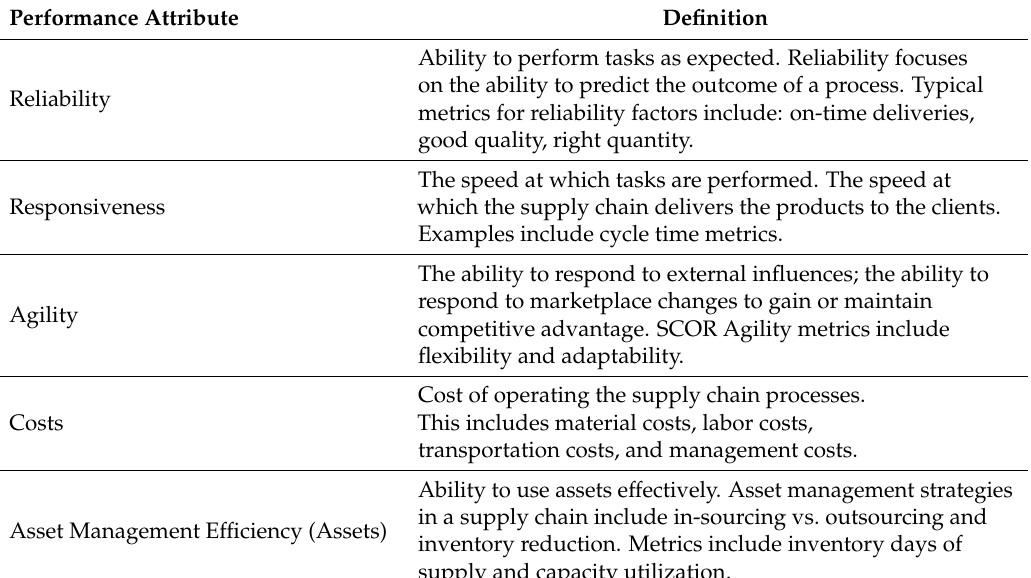
Table 1. Performances attribute of Supply Chain Operations Reference (SCOR)